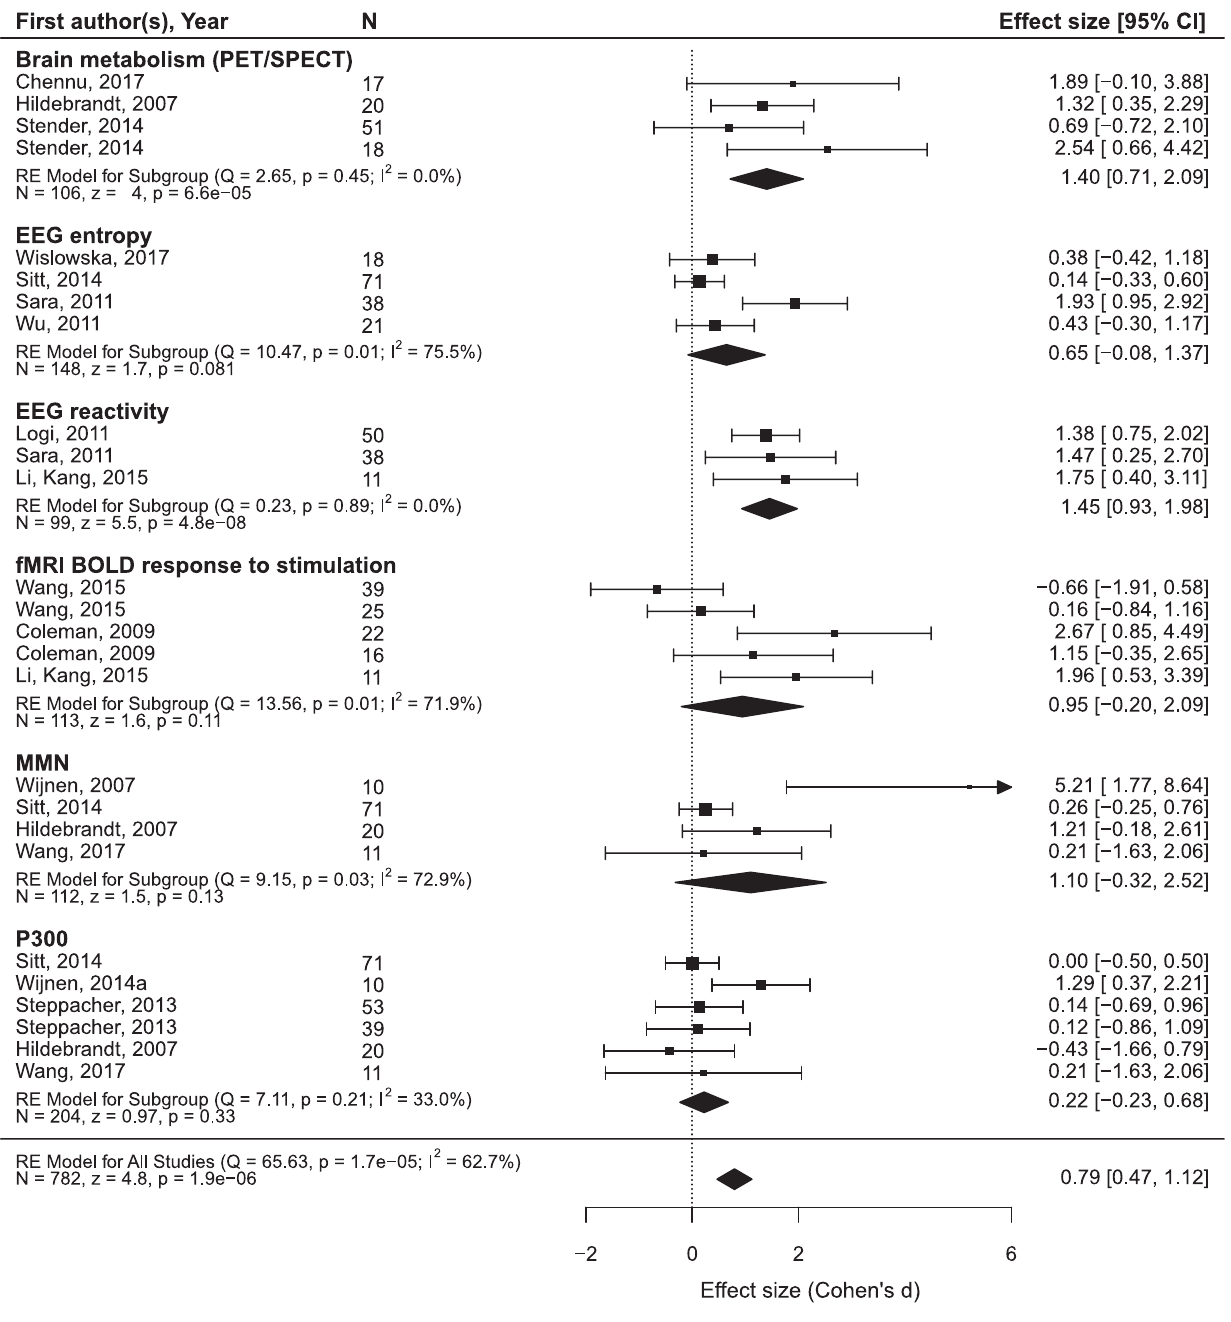
FiguRe 5 | The results of the meta-analysis for prediction of the outcome from neurophysiological variables. The criterion of improvement for all patients was the recovery of consciousness. RE, random effects. The rest is the same as in Figure 3